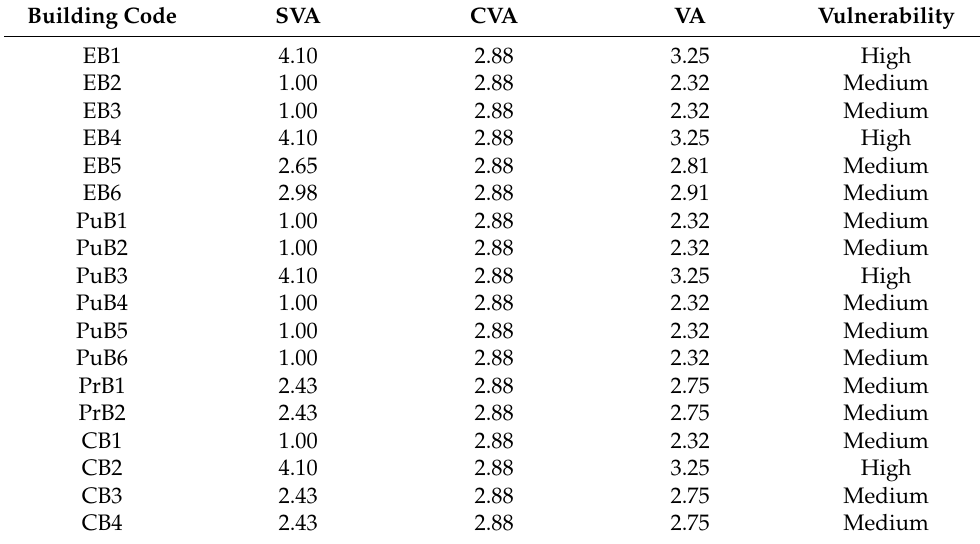
Table 17. Vulnerability assessment results.